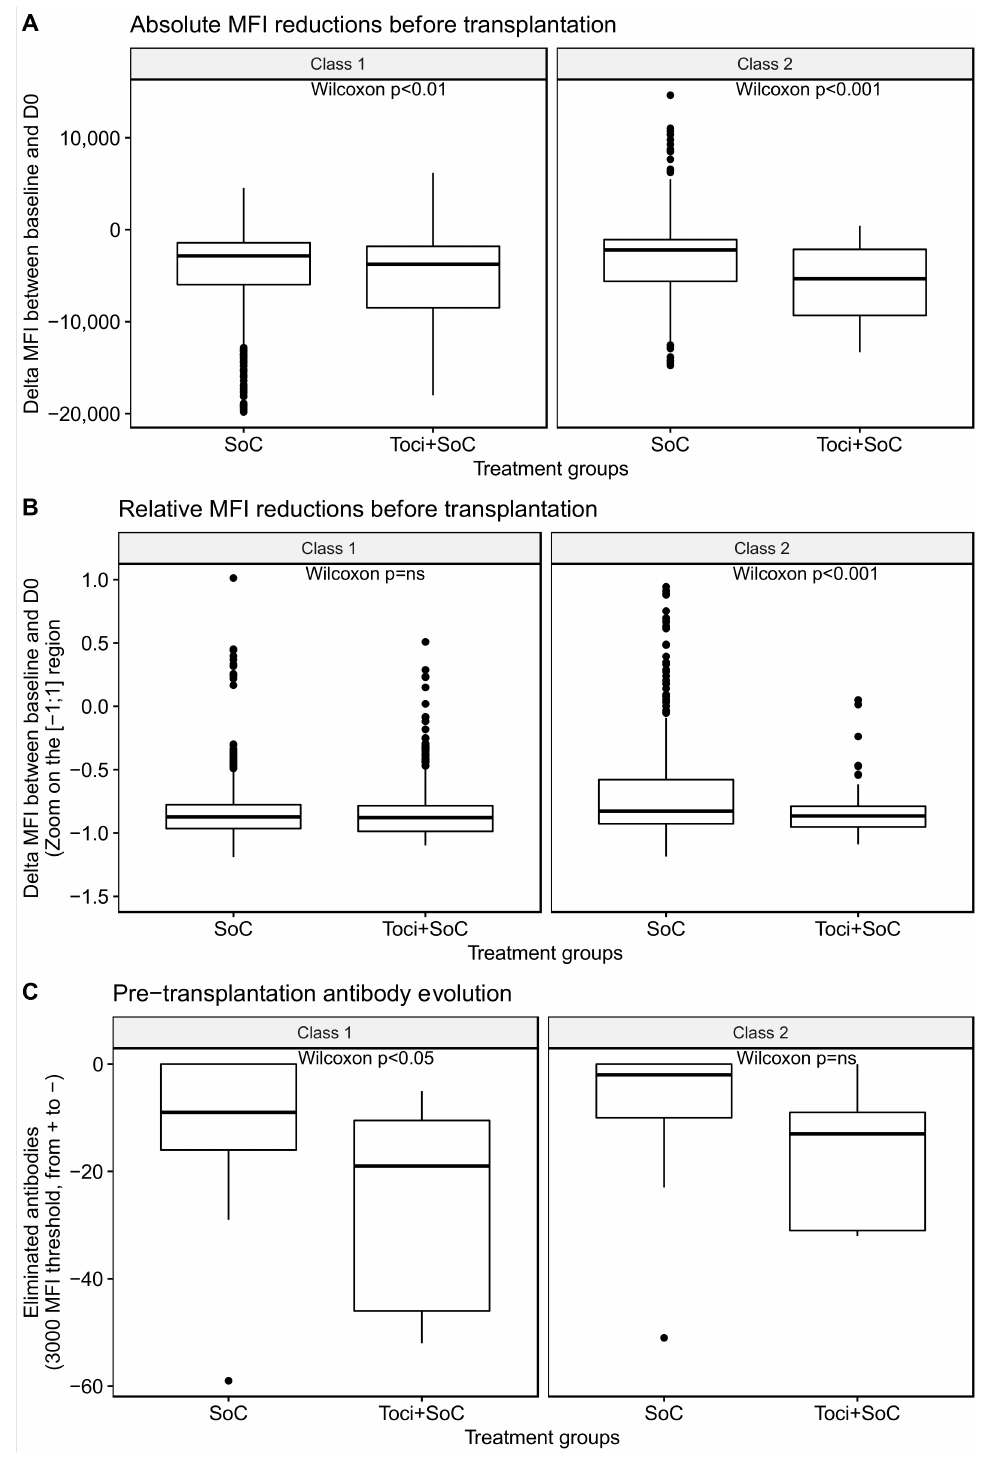
Figure 2. Evolution of MFI and positive antibodies (MFI threshold 3000) over the desensitization process (i.e., before transplantation). ( A ) Absolute MFI reduction per antibody. ( B ) Relative MFI reduction per antibody, with respect to the baseline MFI. ( C ) Number of antibodies for which MFI was higher than 3000 and was reduced to less than 3000, with a minimum absolute delta of 1000. SoC group: 26 patients; Toci + SoC group: 7